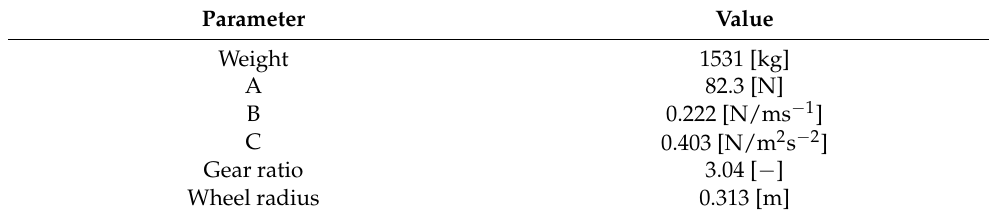
Figure 10. Critical speed and torque points. Table 2. EPA Hybrid Vehicle Parameters.